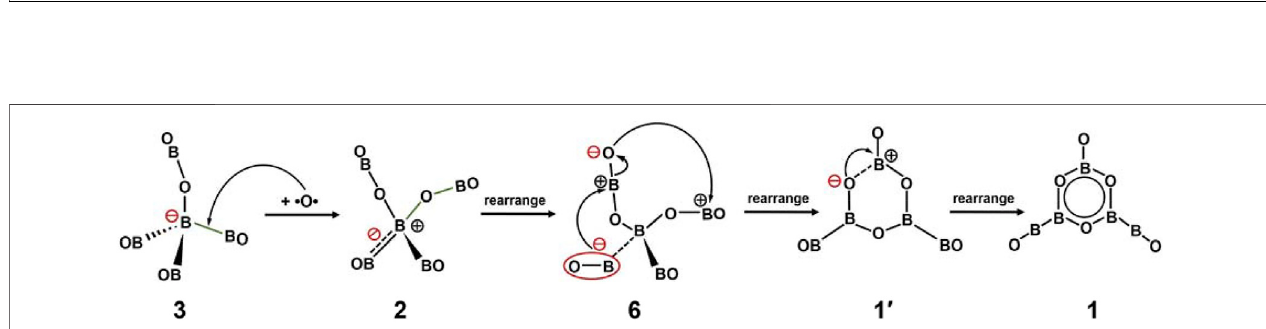
Frontiers in Chemistry |